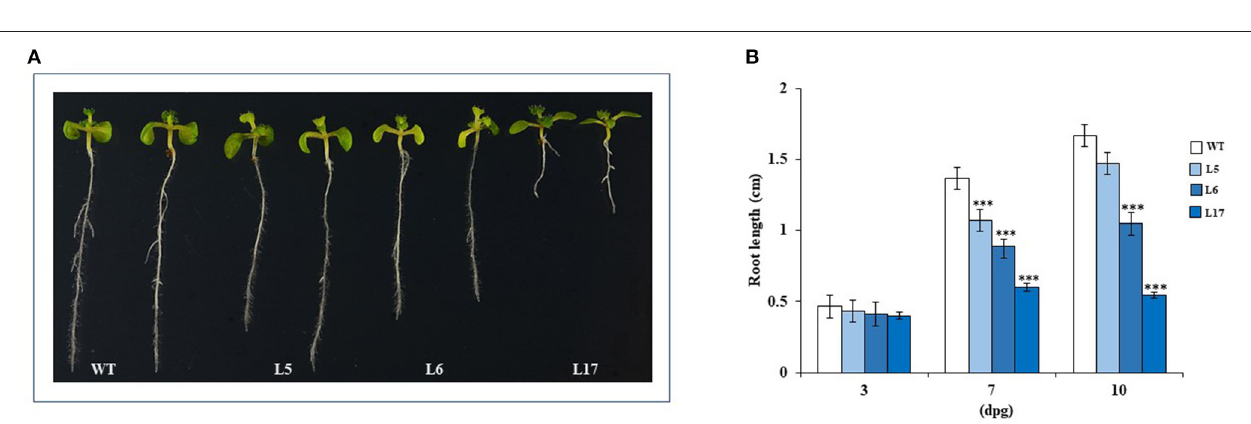
FIGURE 5 | The overexpression of AhN4L-1 in Arabidopsis thaliana plants negatively affects germination and vegetative and reproductive growth. (A) Germination rate, (B) leaf area, (C) inflorescence length, (D) seed weight, and (E) seed yield, were determined in wild type plants (WT) and in three transgenic plant lines (L5, L6, and L17) overexpressing the AhN4L-1 gene at different dosage under long-day conditions. (E) The bars and points in the linear graphs represent the means ± SE of three independent experiments ( n = 10). Asterisks over the bars denote significant differences at P < 0.05 (*), P < 0.01 (**), or P < 0.001 (***) (One-way ANOVA, Tukey-Kramer test).